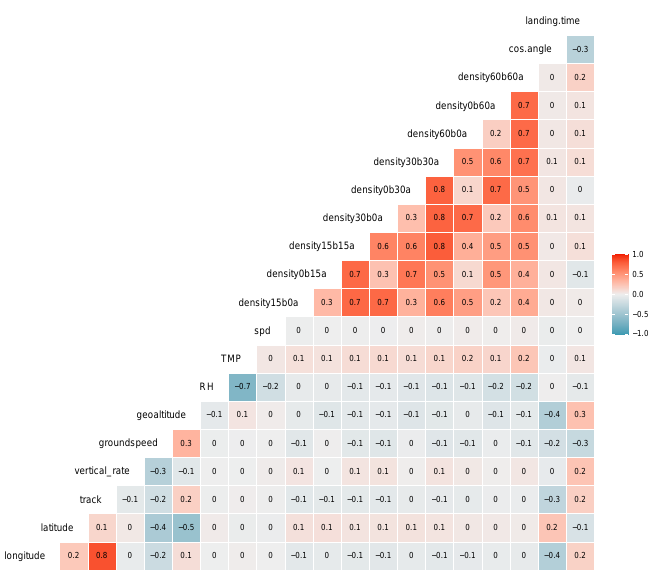
Figure 6. Spearman correlation between features and landing